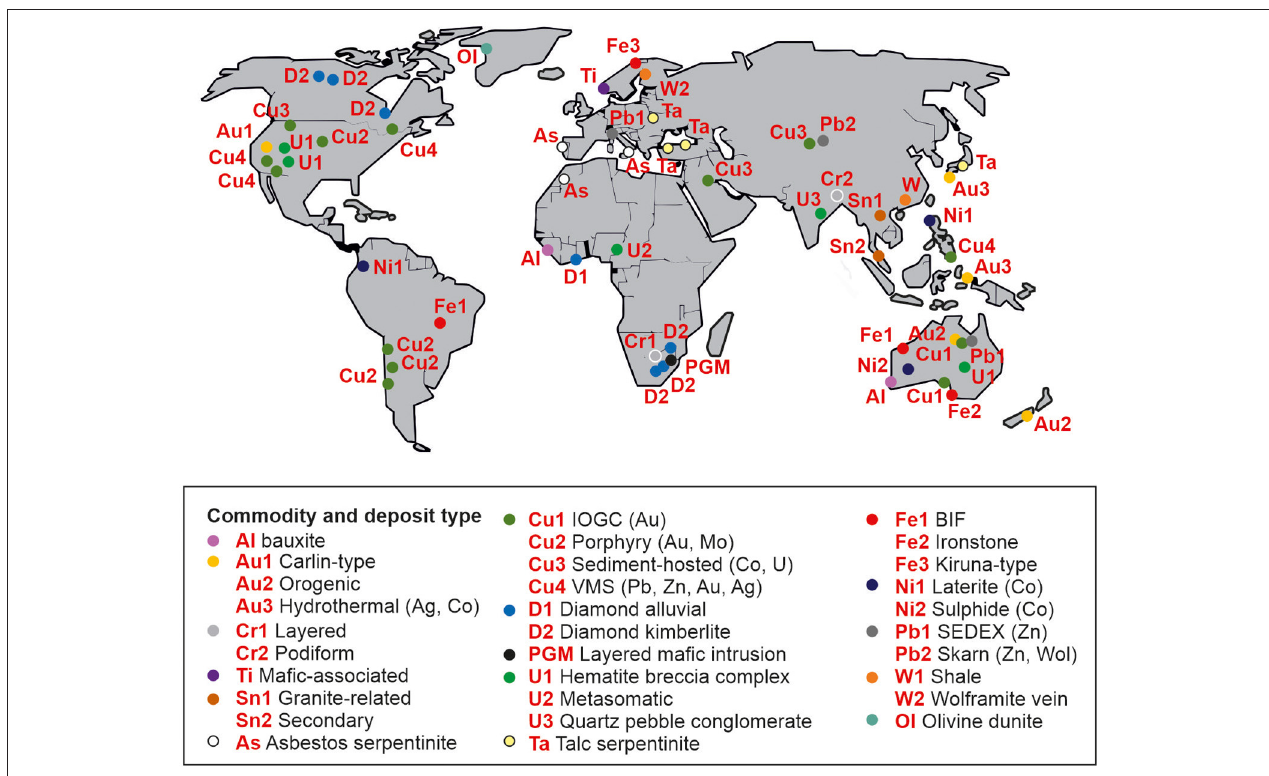
FIGURE 1 | Representative localities of the different mining commodity and deposit types examined in this study. See Supplementary Material 1 for general definitions, references and examples of selected deposit